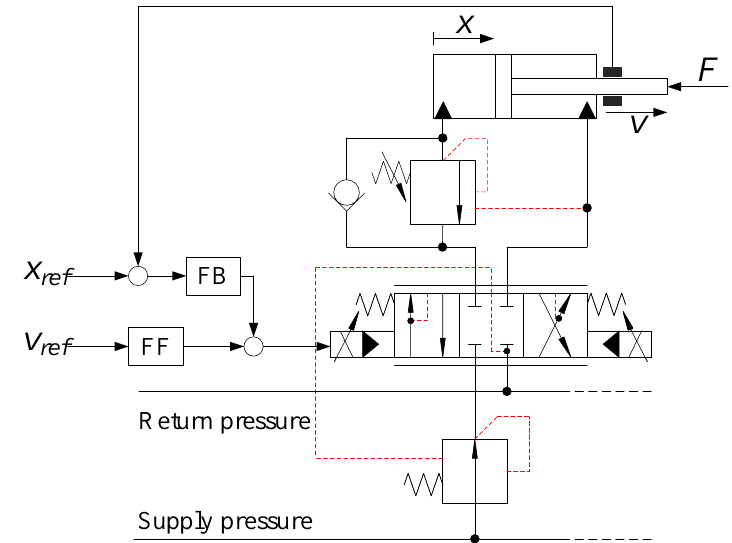
Figure 1. Electro-hydraulic motion control system with